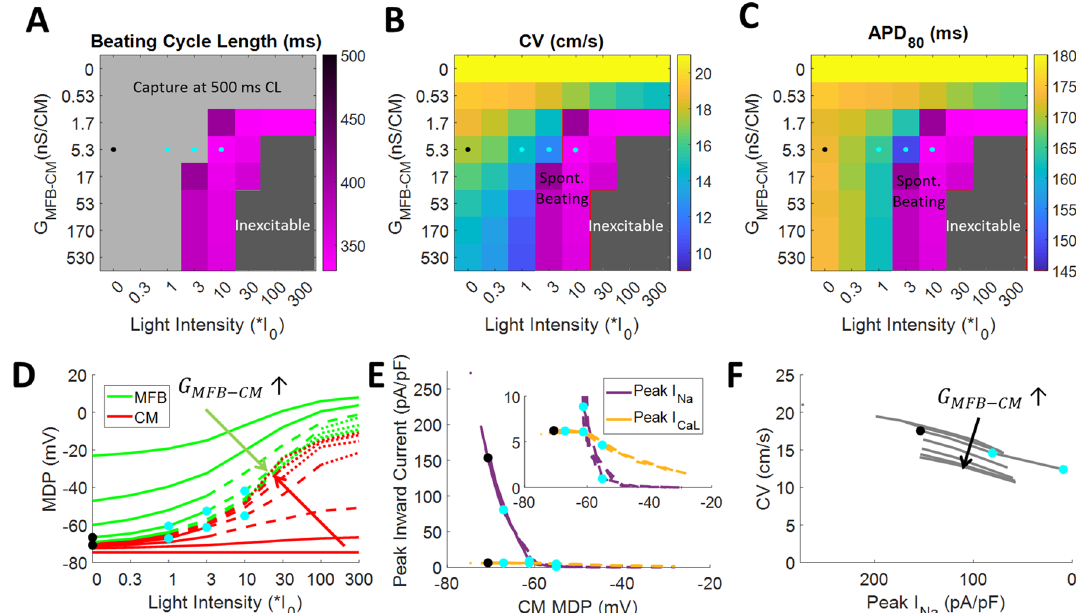
Figure 6. Modeling results of myofibroblasts co-cultured with cardiomyocytes. A cable of 30 pairs of MFBs and CMs in the same 0.4:1 cell ratio used in experiments were paced at 500 ms CL. Color maps show beating cycle length ( A ), conduction velocity ( B ), and APD 80 ( C ) at different MFB-CM conductances ( G MFB-CM ) and light intensities. MFB-CM conductance is varied in half-log 10 increments around the estimated MFB-CM conductance (5.3 nS/CM). Gray region in A denotes that spontaneous beating, if present, was slower than the 500 ms paced CL. CV and APD 80 were not calculated for the purple region in B and C since spontaneous beating prevented capture at 500 ms CL pacing. Dark gray region denotes that cells were inexcitable. Black dots indicate modeled values without light, and blue dots indicate modeled values at light power levels used in experiments, all at the estimated MFB-CM conductance of 5.3 nS/CM. ( D ) Maximum diastolic potential (MDP) of MFBs (green) and CMs (red). ( E ) Peak inward sodium current (purple) and L-type calcium current (gold) versus CM maximum diastolic potential. Inset shows same data with an expanded scale. ( F ) Conduction velocity versus peak sodium current. ( D–F ) MFB-CM conductance starts at 0 then increases in half-log 10 increments from 5.3*10 –1 nS/CM to 5.3*10 2 nS/CM. Solid lines show conditions that allowed capture at the 500 ms paced CL. Dashed lines show conditions that caused spontaneous beating in excess of the pacing rate. Dotted lines show conditions that caused cells to be inexcitable. Black dots indicate modeled values without light and blue dots indicate modelled values at light power levels used in experiments, all at the estimated MFB-CM conductance of 5.3